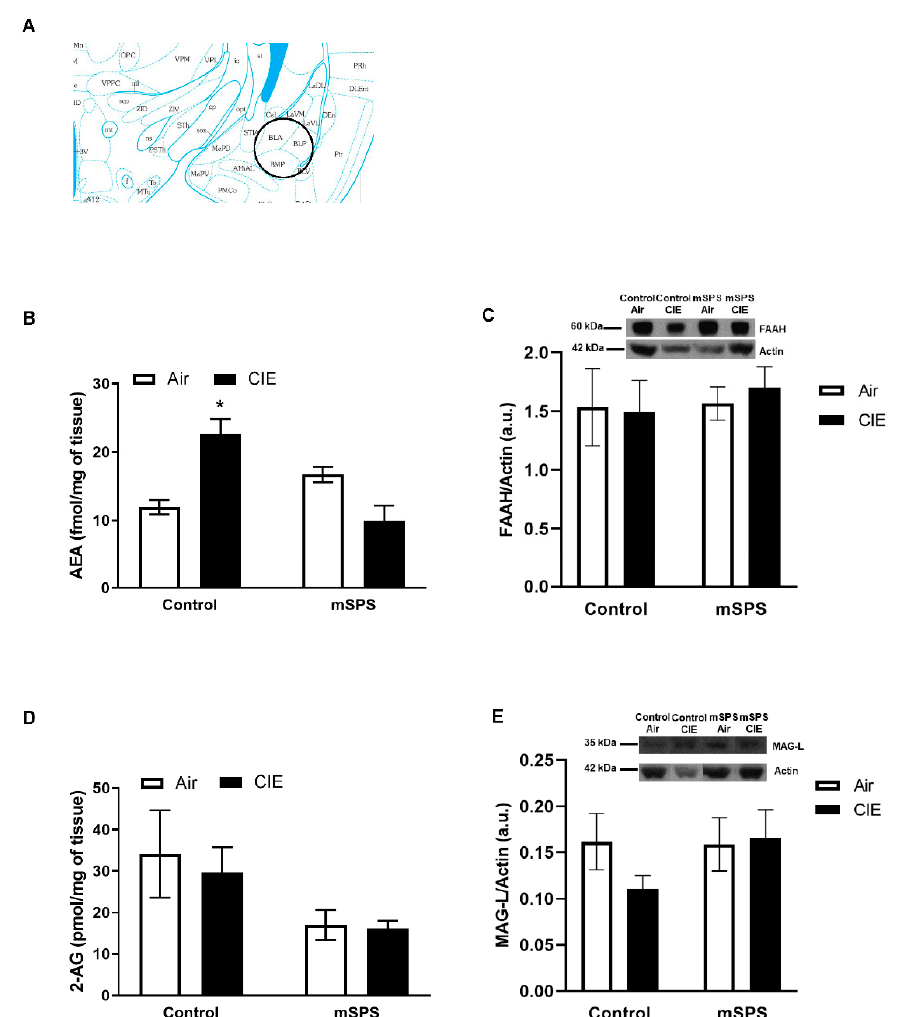
Figure 5. Anandamide (AEA) and 2-arachidonoylglycerol (2-AG) contents, fatty acid amide hydrolase (FAAH) and monoacylglycerol lipase (MAG-L) levels in the amygdala (AMYG) after mSPS/Control or Air/CIE exposures. ( A ) Schematic of coronal slice where AMYG tissue punches were taken bilaterally (adapted from [58]). Average ( B ) AEA content (Control-Air: n = 6; Control CIE: n = 6; mSPS-Air: n = 6; mSPS-CIE: n = 8) increased in Control-CIE mice (* p < 0.05) compared to Control-Air or mSPS-CIE mice after mSPS/Control or Air/CIE exposures. However, the average ( C ) FAAH levels (Control-Air: n = 7; Control CIE: n = 4; mSPS-Air: n = 5; mSPS-CIE: n = 8) (Inset: representative immunoblotting sample images) did not change among groups after mSPS/Control or Air/CIE exposures. In addition, average ( D ) 2-AG content (Control-Air: n = 6; Control CIE: n = 6; mSPS-Air: n = 6; mSPS-CIE: n = 7) and ( E ) MAG-L levels (Control-Air: n = 6; Control CIE: n = 3; mSPS-Air: n = 5; mSPS-CIE: n = 8) (Inset: representative immunoblotting sample images) did not change among groups. Data are mean ±